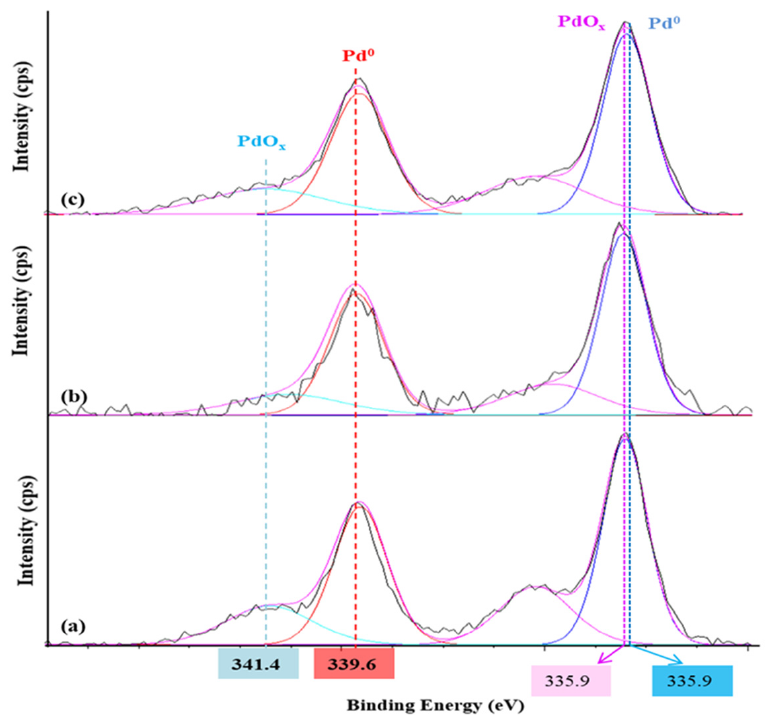
Figure 3. XRD patterns of Pd/TiO 2 _x catalysts: (a) x = 100; (b) x = 50; (c) x = 20; (d) Pd/TiO 2 _citrate free after drying at 70 °C for 24 h.